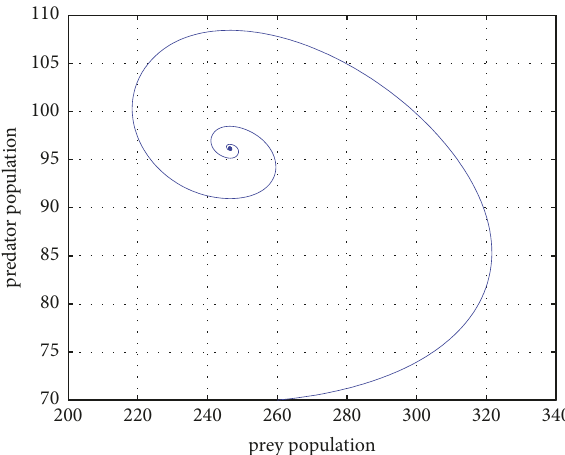
Figure 1: The phase portrait of model (2) with weak Allee effect. The parameters are taken as 𝐴 = 0.01 , 𝑟 = 2.65 , 𝐾 = 900 , 𝑎 = 0.002 , 𝑐 = 0.215 , and 𝑚 = 1.06 ; 𝐸 = (𝐾,0) is locally asymptotically stable. 1